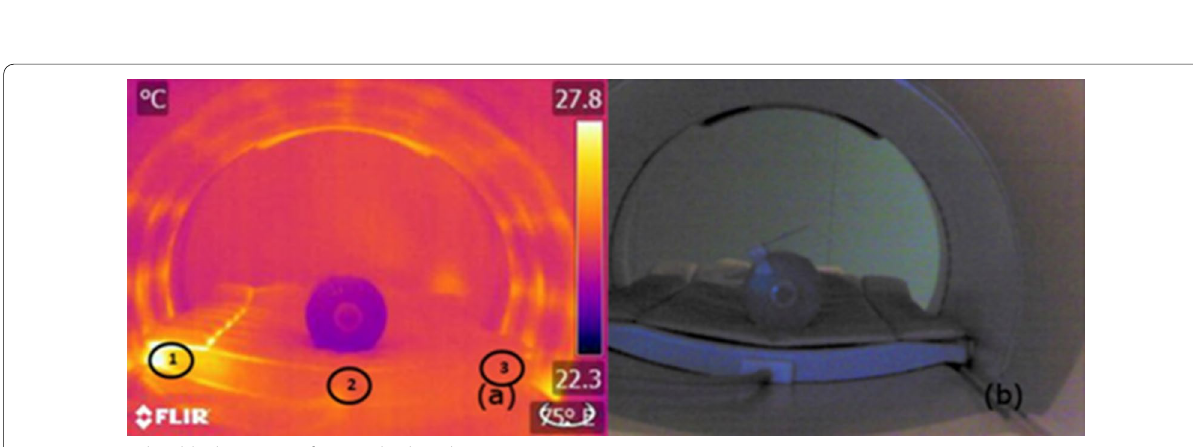
Fig. 4 IR ( a ) and Visible ( b) images of 1.5 MRI body